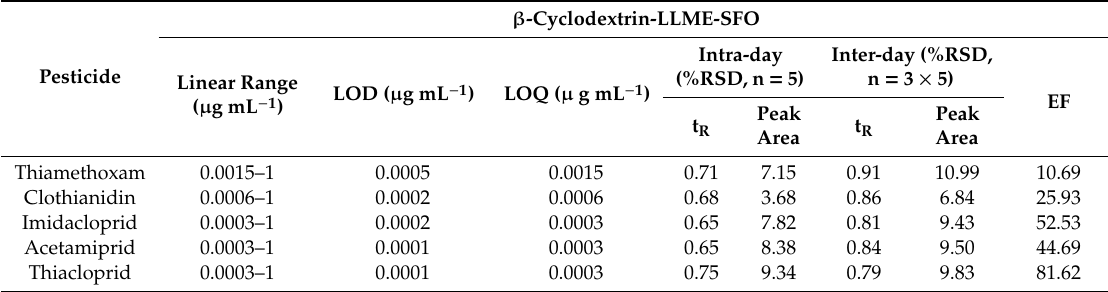
Table 1. Analytical performance of the β -Cyclodextrin-LLME-SFO method.